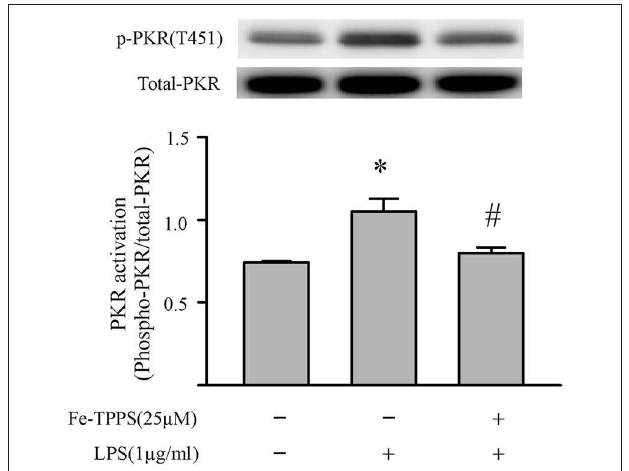
FIGURE 10 | A peroxynitrite decomposition catalyst (Fe-TPPS) prevents the LPS-induced PKR phosphorylation. Fibroblasts were pretreated with Fe-TPPS (25 µ M) or vehicle for 30min and subsequently challenged with LPS (1 µ g) for an additional 15min (see Figure 2 for time course). Thereafter, the fibroblasts were harvested for assessment of PKR phosphorylation on the activation threonine 451 (p-PKR [T451]). Representative Western blot is shown above and densitometric analysis below. n = 3, * p < 0.05 as compared with control; # p < 0.05 as compared with LPS.